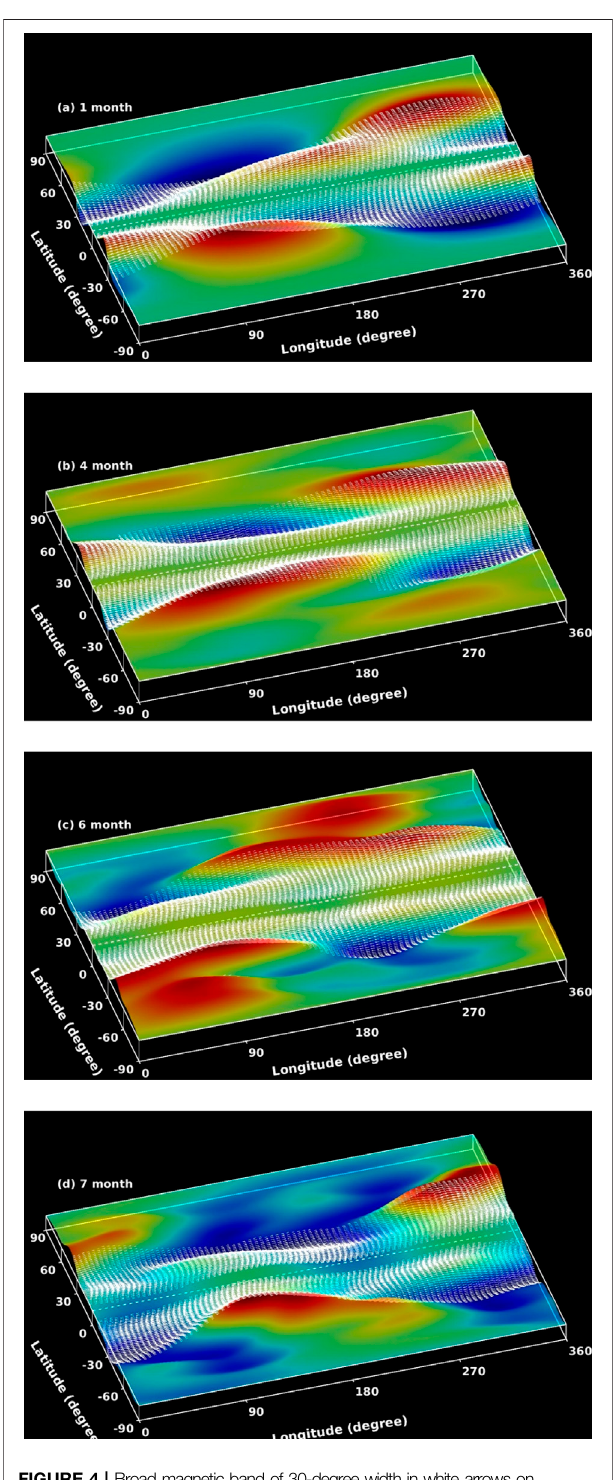
FIGURE 4 | Broad magnetic band of 30-degree width in white arrows on tachocline top surface, which is presented in rainbow colormap. Red/orange represents bulges and deep-blue/blue the depression in plasma fl uid. Panels (A – D) show the nonlinear evolution of the magnetic band due to the interaction of Rossby waves, which work on the mean differential rotation and spot-producing toroidal fi elds as perturbation. The times for these four snapshots are selected nonuniformly,tocapturetheimportantdynamics,respectivelyat1,4,6and7 months.